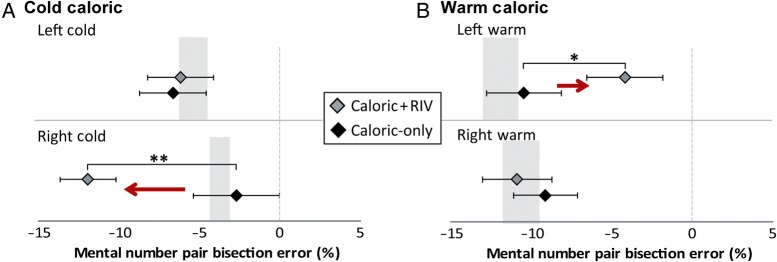
Results from mental number pair bisection experiments following physiological manipulations. We present the mean % bisection error from the midpoint of the numerical interval. (A) “Caloric + RIV” condition (gray diamonds) resulted in subjects significantly underestimating the midpoint (i.e., shift to the left as indicated by red arrow) compared with “Caloric-only” (black diamonds) condition following RIGHTCOLD + RIV (LOWER PANEL), but no effect was found during LEFTCOLD + RIV (upper panel). (B) During LEFTWARM + RIV, the subjects demonstrated a significant shift toward larger numbers (i.e., rightward shift as indicated by red arrow), suggesting overestimation of the midpoint (upper panel). No effect of RIGHTWARM + RIV was observed (lower panel). Gray-shaded area in panels indicates 95% confidence limits calculated from baseline measures (i.e., no caloric or BR stimulation). Dashed line at 0 corresponds to 0% error, i.e., accurate bisection. Data marked ** are significant at P < 0.01; data marked * are significant at P < 0.05. Error bars indicate standard errors.